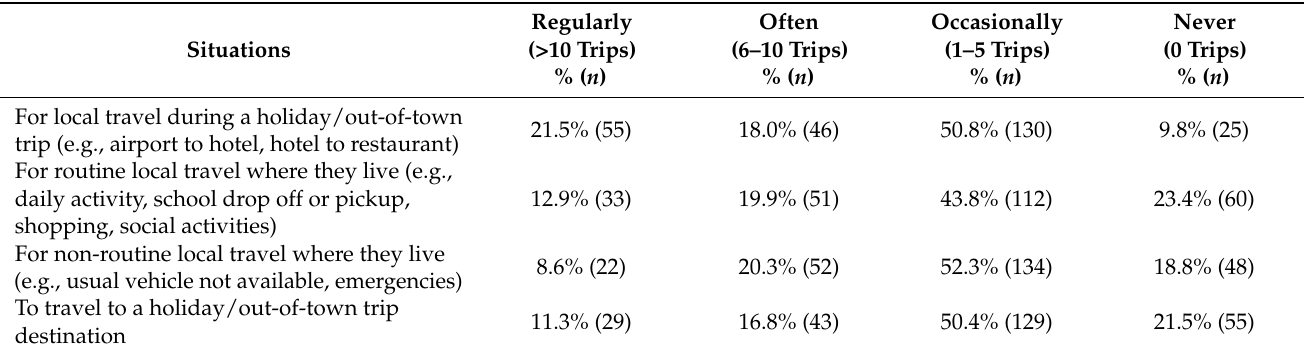
Table 6. Situations (and frequency) that participants used rideshare services to travel with their youngest child over the past two years ( n = 256).